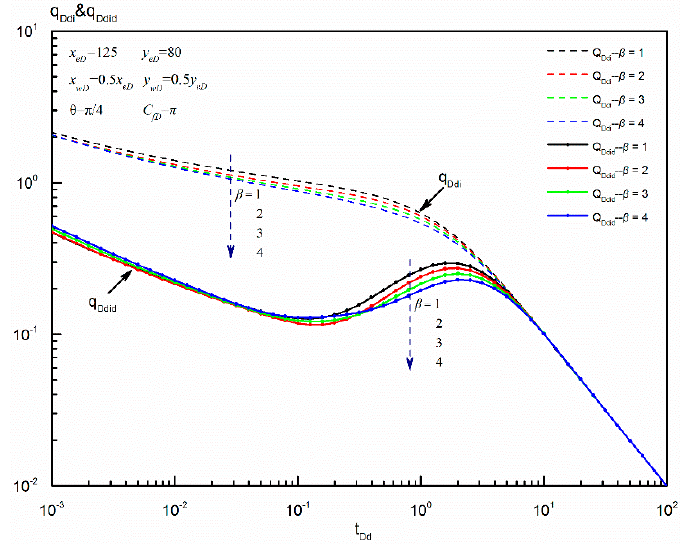
Figure 14. Blasingame format curves for a fractured well in an anisotropic rectangular reservoir at di ff erent values of permeability anisotropy.